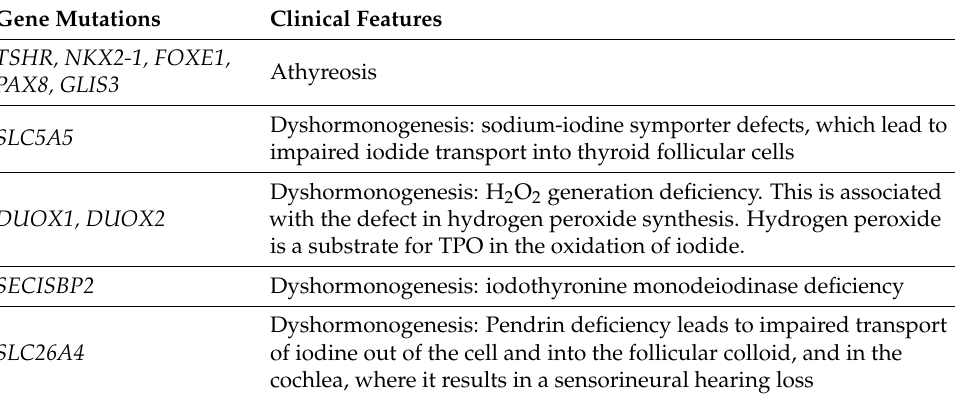
Table 1. Genetic mutations causing congenital hypothyroidism